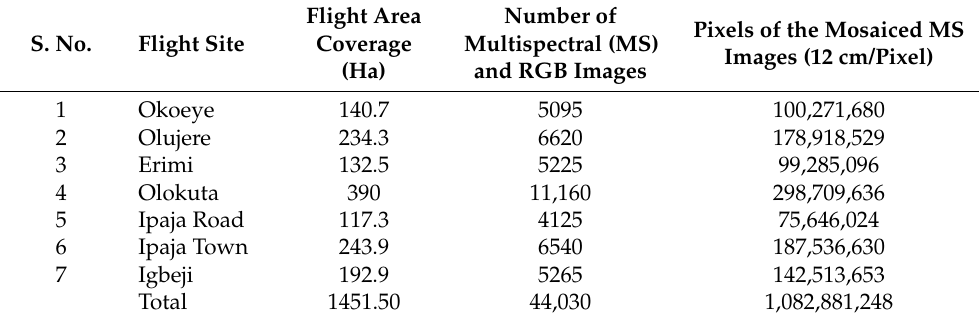
Table 1. Details of the UAV flight sites, land area covered, and images collected during flight missions.